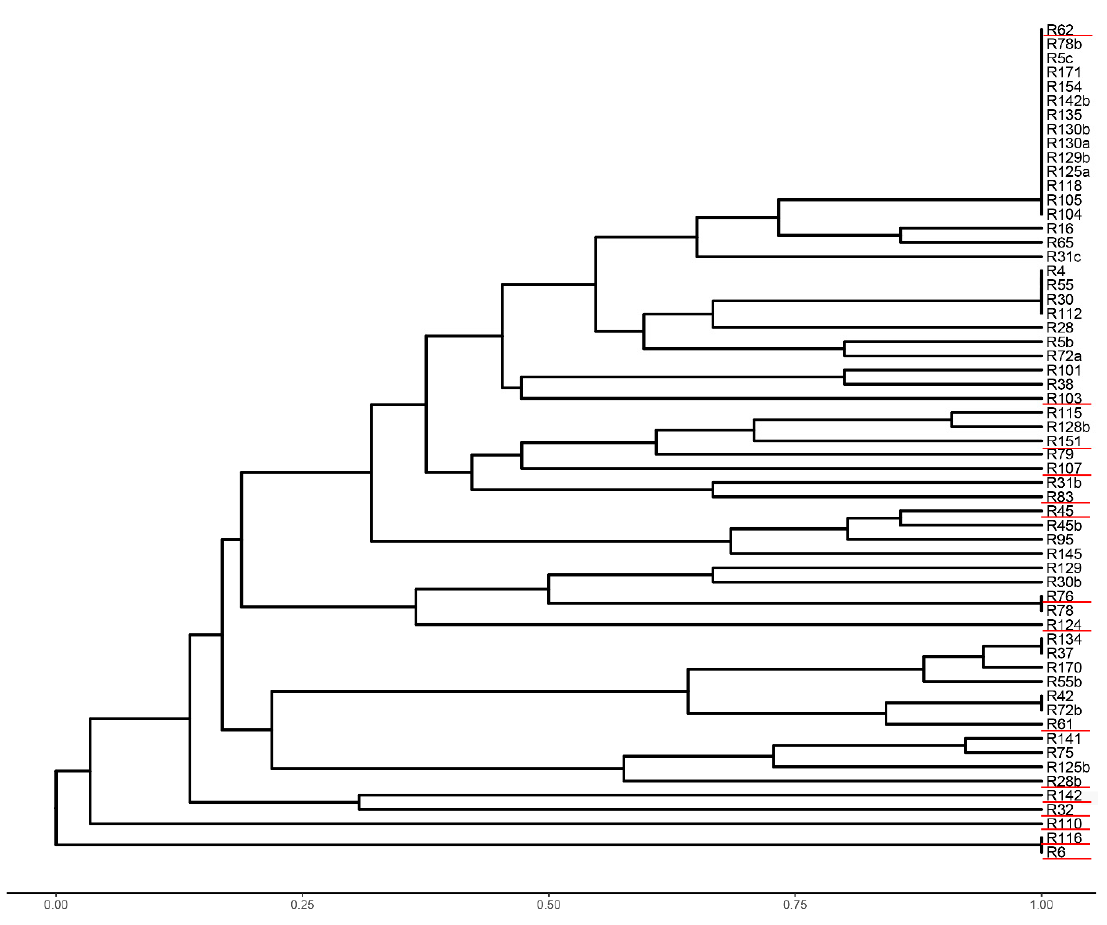
Figure 1. Phylogenetic tree based on the Enterobacterial Repetitive Intergenic Consensus Polymerase Chain Reaction (ERIC-PCR) (strains selected for further analysis are underlined).